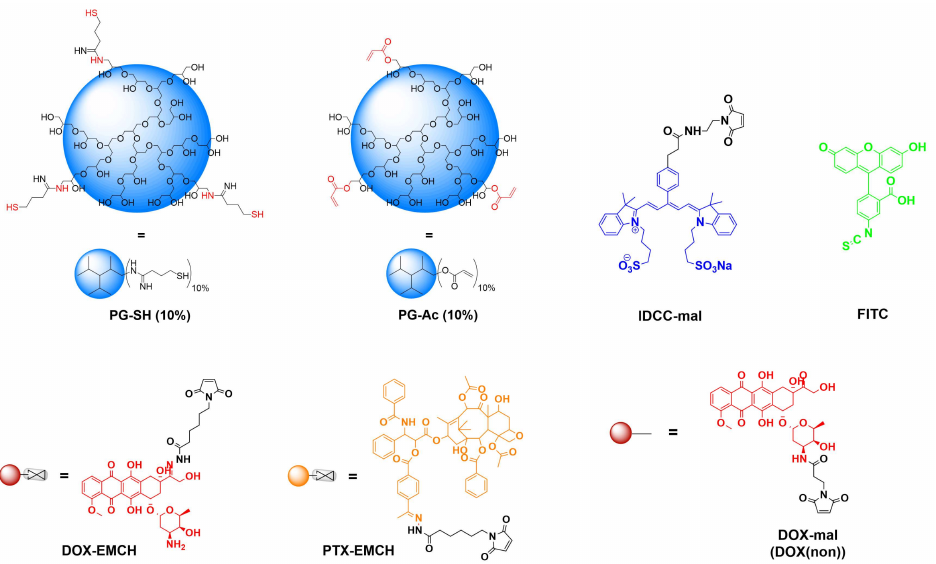
Figure 2. Building blocks for NG synthesis.